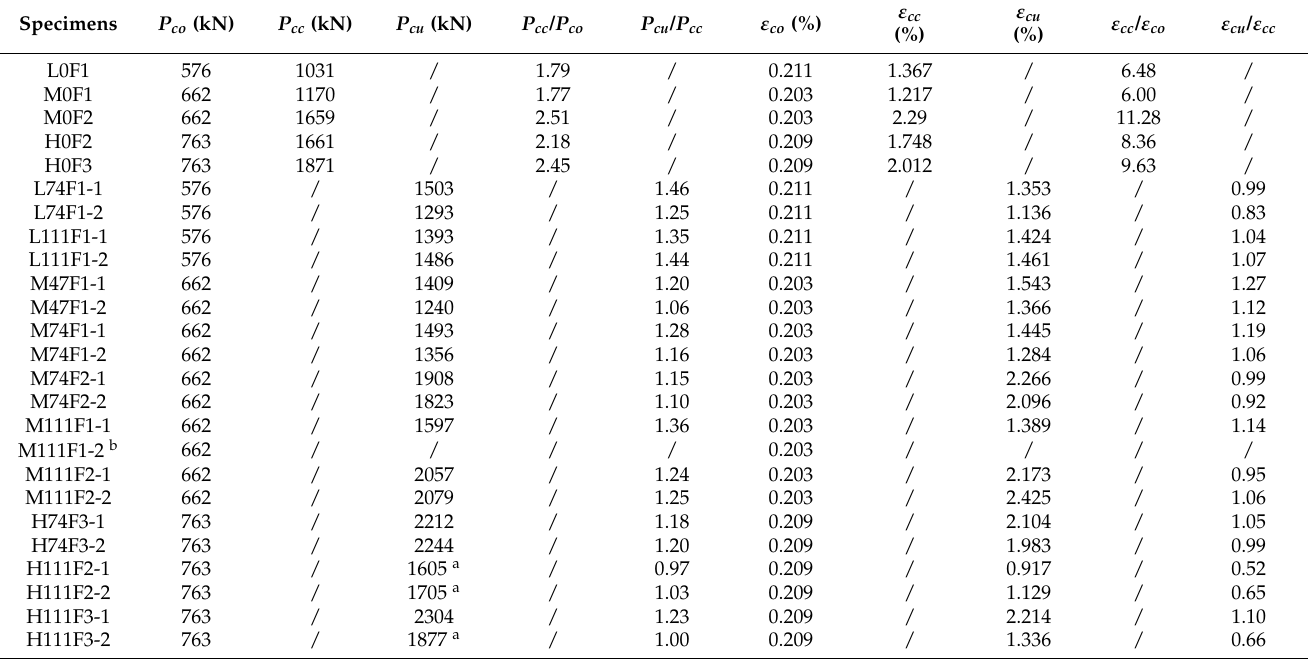
Table 4. Key results of all test